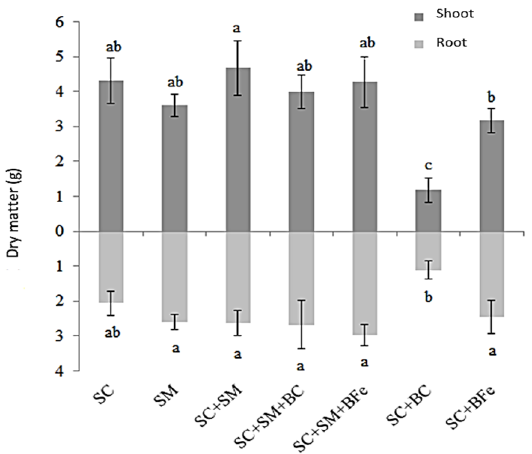
Figure 4. Dry matter of shoot and root of Ipomoea asarifolia . SC = contaminated soil, SM = forest soil, SC + SM = contaminated soil + forest soil, SC + SM + BC = contaminated soil + forest soil + biochar, SC + SM + BFe = contaminated soil + forest soil + biochar Fe impregnated, SC + BC = contaminated soil + biochar, SC + BFe = contaminated soil + biochar Fe impregnated. Mean values with standard deviation bars. Values with the same letter are not significant by the Tukey test ( p < 0.05), n =